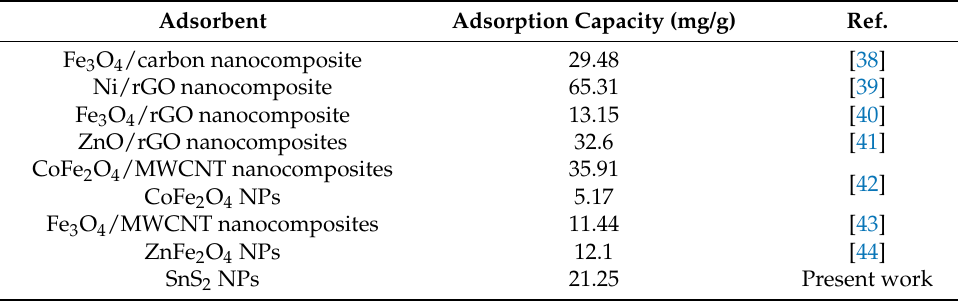
Table 1. Comparison of the adsorption capacity of SnS 2 nanoparticles with other adsorbent nanoparticles and nanocomposites.